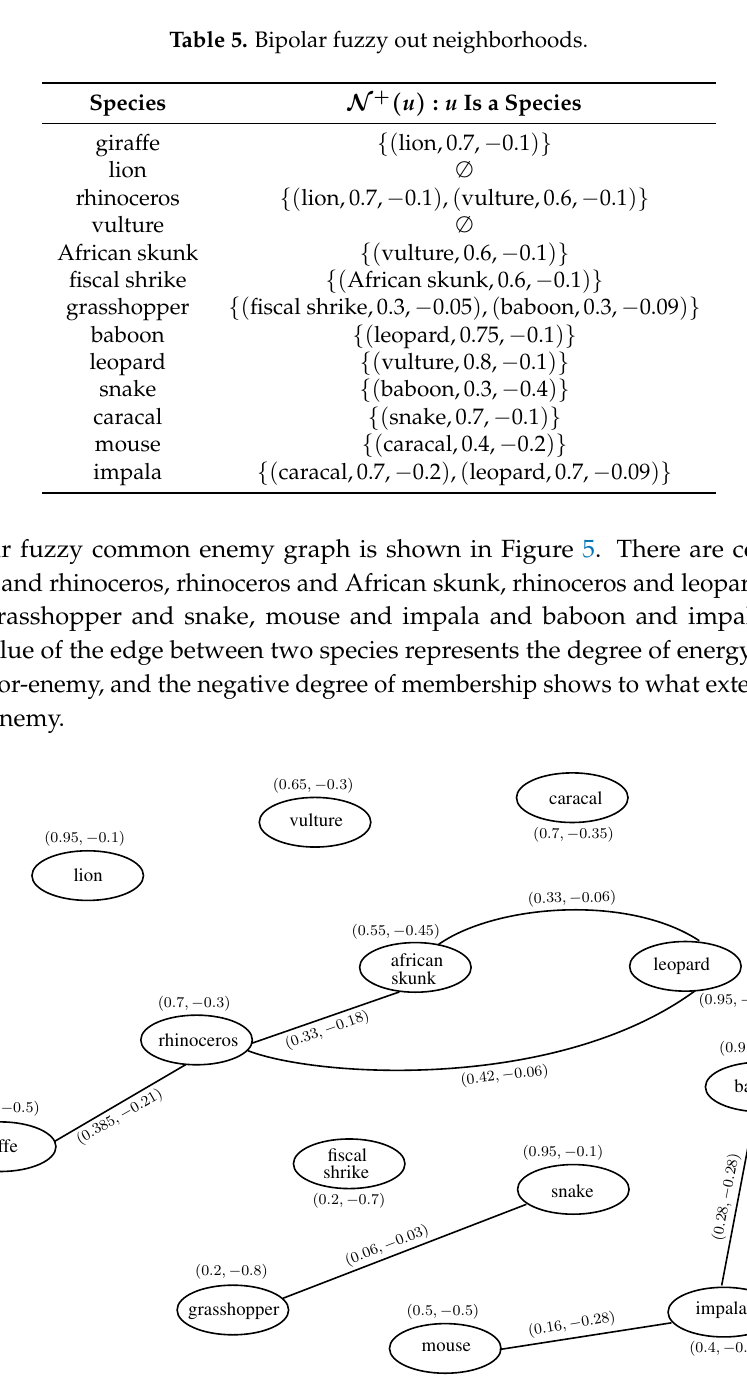
Figure 2.5: 4 polar fuzzy common enemy graph Figure 5. Quadripolar fuzzy common enemy −